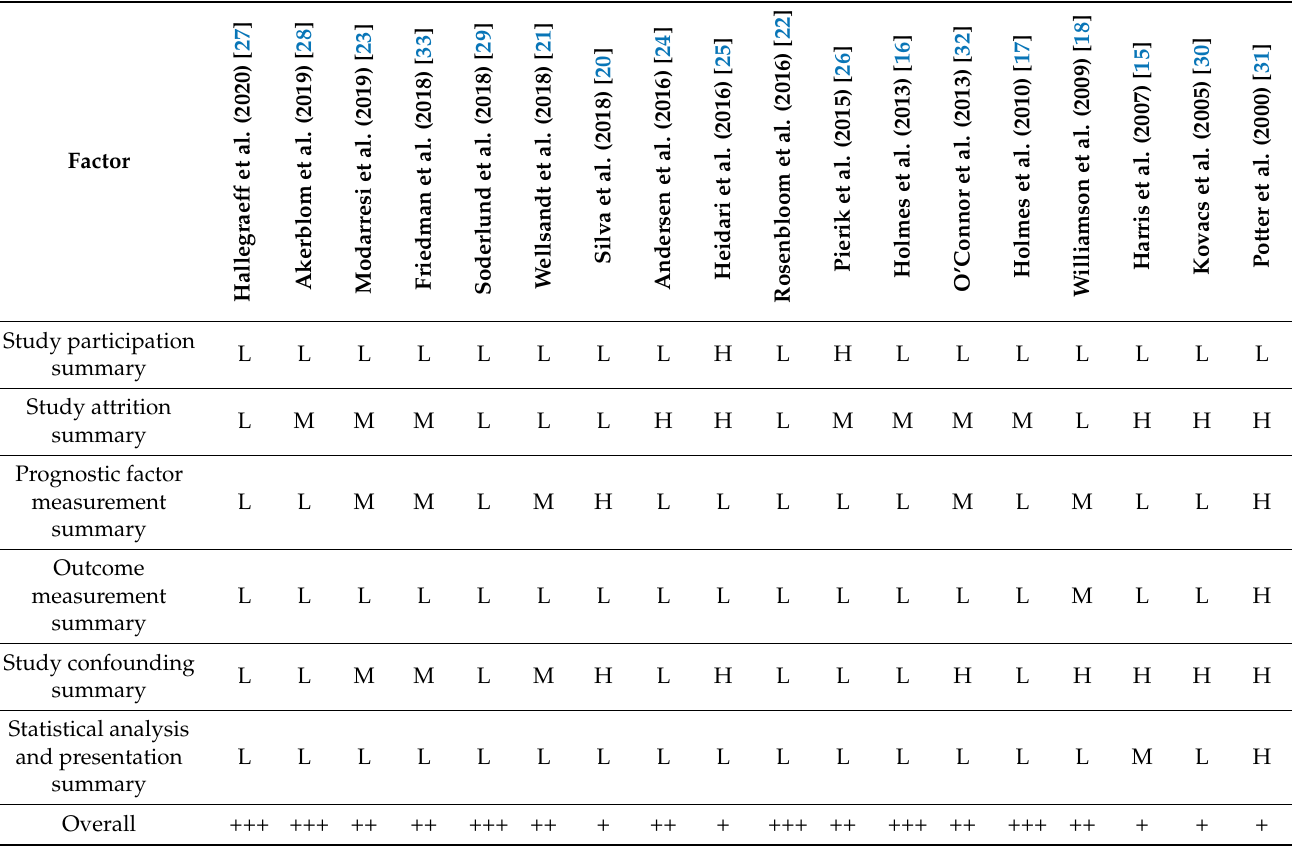
Table 2. Quality scores from the 18 included